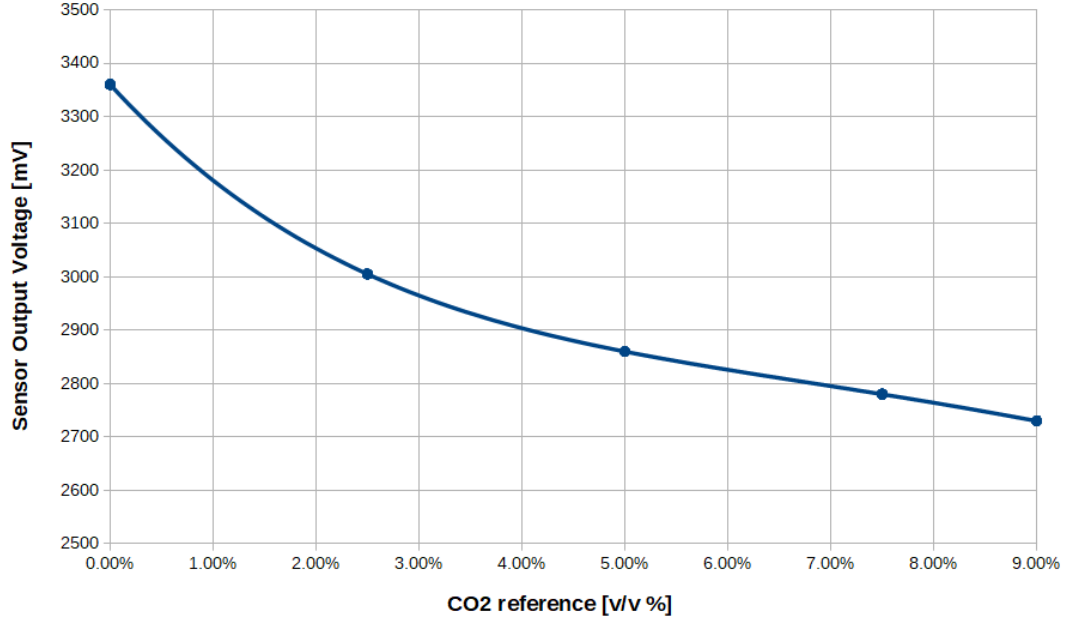
Figure 16. Example of calibration curve. Dots represent the values used for polynomial